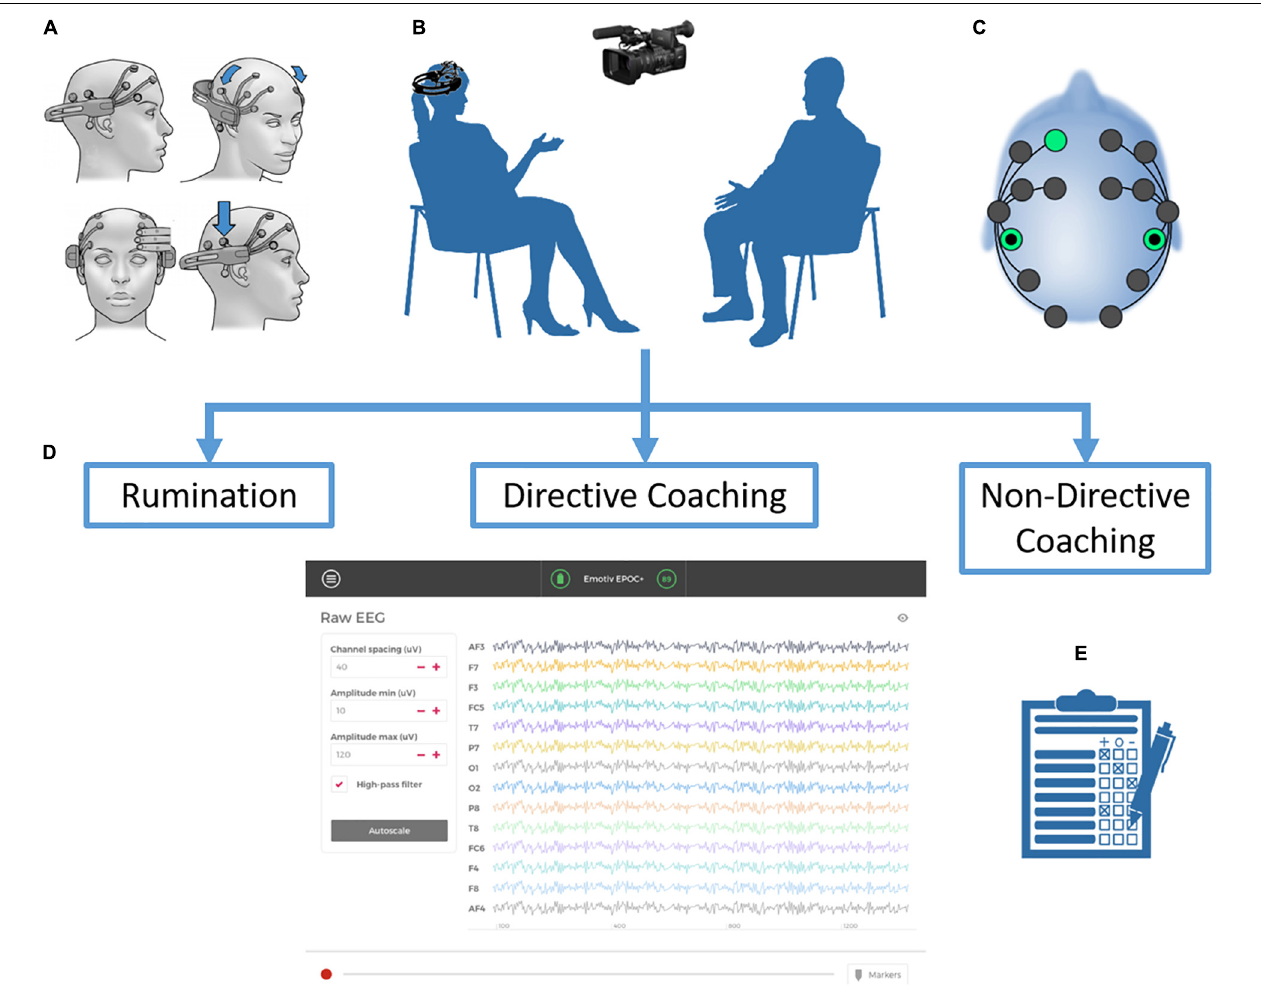
FIGURE 1 | Schematic illustration of the experimental procedure performed in each experimental session during electroencephalographic (EEG) acquisition data. (A) One wireless EEG device (Emotiv EPOC+) with non-invasive electrodes (14 channels) was placed on the forehead subject according to the International 10–20 system before data-collection. (B) Subjects were informed about the instructions, procedure followed during the session (free-choice and order of three goals or problems to resolve) and tips in order to ensure good EEG recording. Each session was video recorded to analyze the relationship between insights and goal, reality, options, and will (GROW) coaching model phases. (C) Spatial mapping of the electrodes’ current connection status on the scalp (color code: green, good connection; black, not providing information). Data recording was started when all electrodes had good connectivity. EEG baseline was registered with closed and open eyes (both for 30 s). (D) Participants were guided during each individual session to resolve a problem by rumination (no coaching), directive coaching, and non-directive coaching approaches while EEG brain activity was recorded, identifying every moment of creative insight (even-related markers). (E) After EEG data acquisition, the creativity self-assessment scale was filled